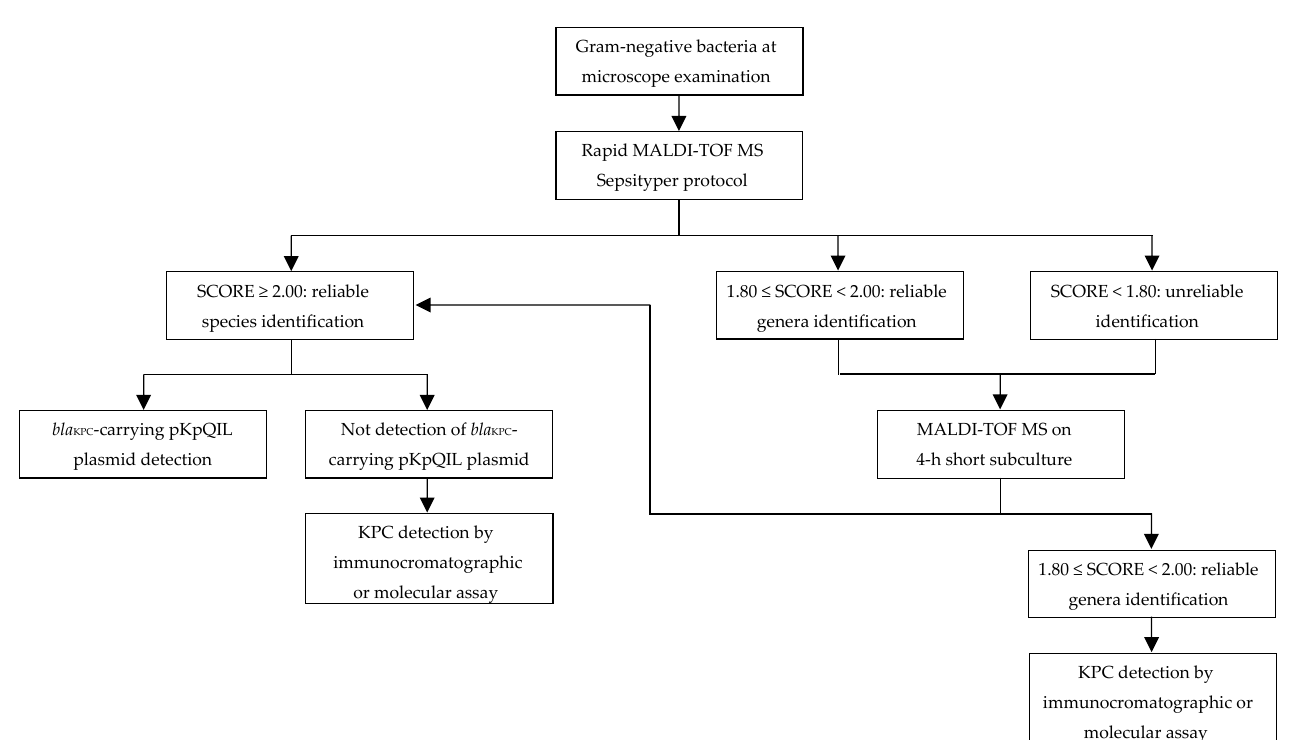
Figure 1. Blood cultures rapid diagnostic algorithm for identification of Gram-negative bacteria and KPC